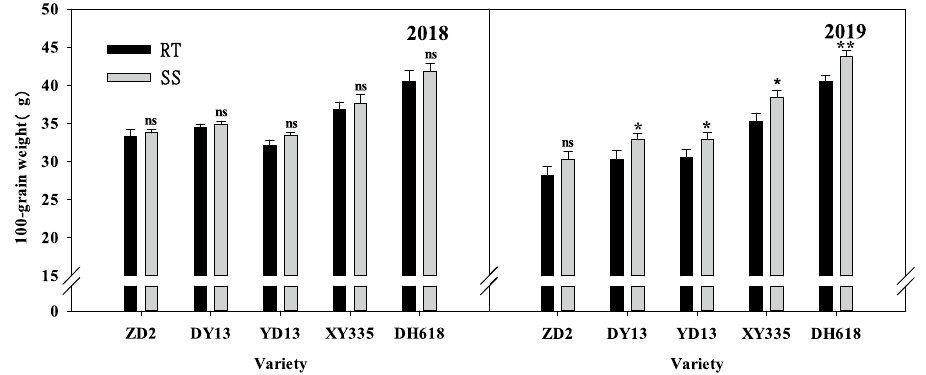
Figure 2. Effects of subsoiling tillage on the 100-grain weight of different ages maize varieties. *,** and ns represent the ANOVA analysis between RT and SS, *Significant at P , 0.05. **Significant at P , 0.01. “ns” no significant at P , 0.05.